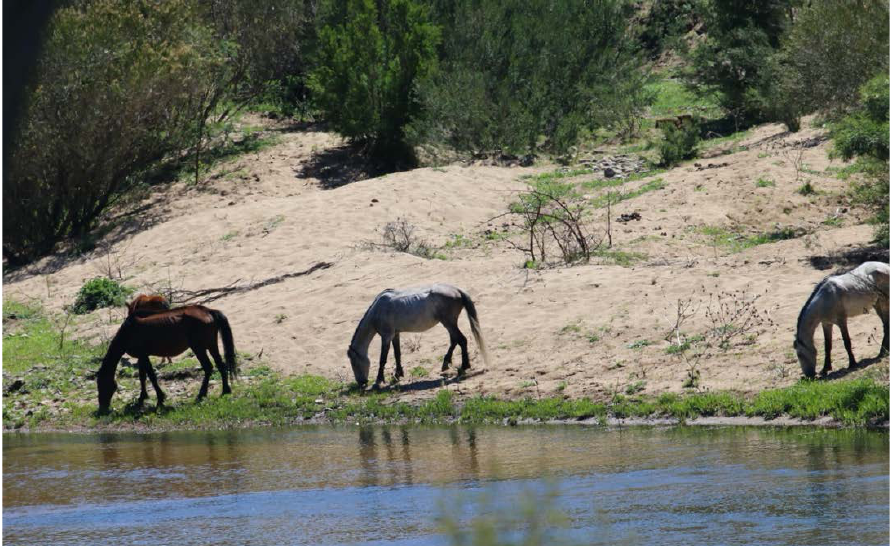
Figure 1. Wild horses grazing on the edge of the Lower Snowy River, NSW, Australia. Image A. M. Harvey.